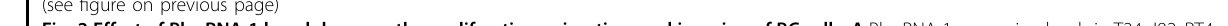
Fig. 2 Effect of PlncRNA-1 knockdown on the proliferation, migration, and invasion of BC cells. A PlncRNA-1 expression levels in T24, J82, RT4, and 5637 BC cells. B qPCR analysis for the transfection ef fi ciency of PlncRNA-1-siRNA in T24 and 5637 BC cells. C , D . CCK-8 assay for the proliferation of T24 and 5637 cells after PlncRNA-1 silencing. E , F Colony formation assay for the proliferative capacity of T24 and 5637 BC cell lines after PlncRNA-1 silencing. G – I . Wound healing assays for the migration of T24 and 5637 BC cells after PlncRNA-1 silencing (Scale bar, 200 μ m). J – L Transwell migration and invasion assays for the migration and invasion of T24 and 5637 after PlncRNA-1 silencing (Scale bar, 100 μ m). M , N Western blot analysis of the impact of PlncRNA-1 on EMT progression.